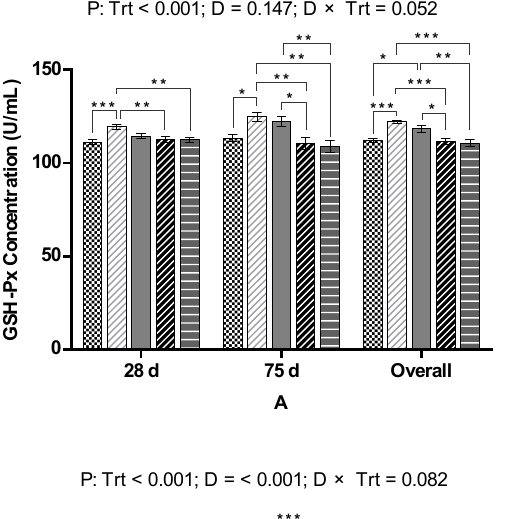
concentration of MDA ( p < 0.05), compared to the CON. Activity of CAT was significantly lower in PE40 than in all groups ( p < 0.05).